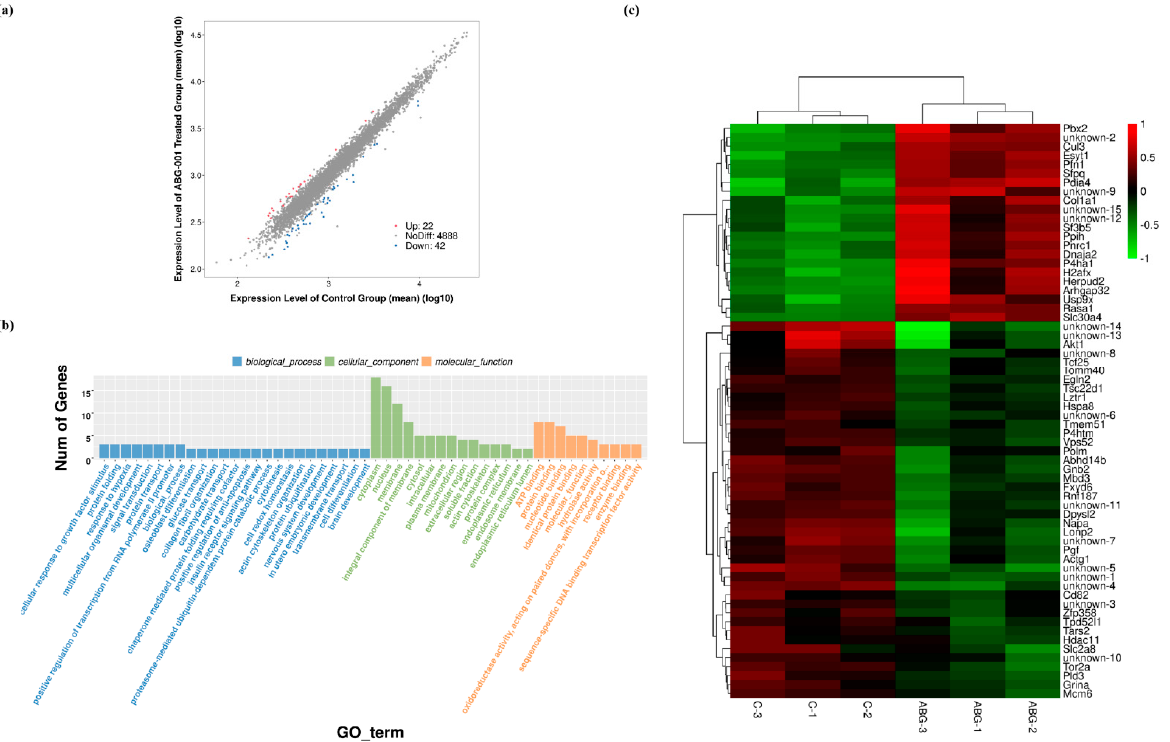
Figure 1. Microarray analytical results of ABG-001. ( a ) Profiles of differentially expressed mRNAs in the control group and ABG-001 treated groups. ( b ) Significant GO categories of the differentially expressed genes for the upregulated and downregulated genes. ( c ) Heatmap of differential expression genes compared with control group and ABG-001 groups. The red and green colors represent the upregulation and downregulation of genes expression, respectively.